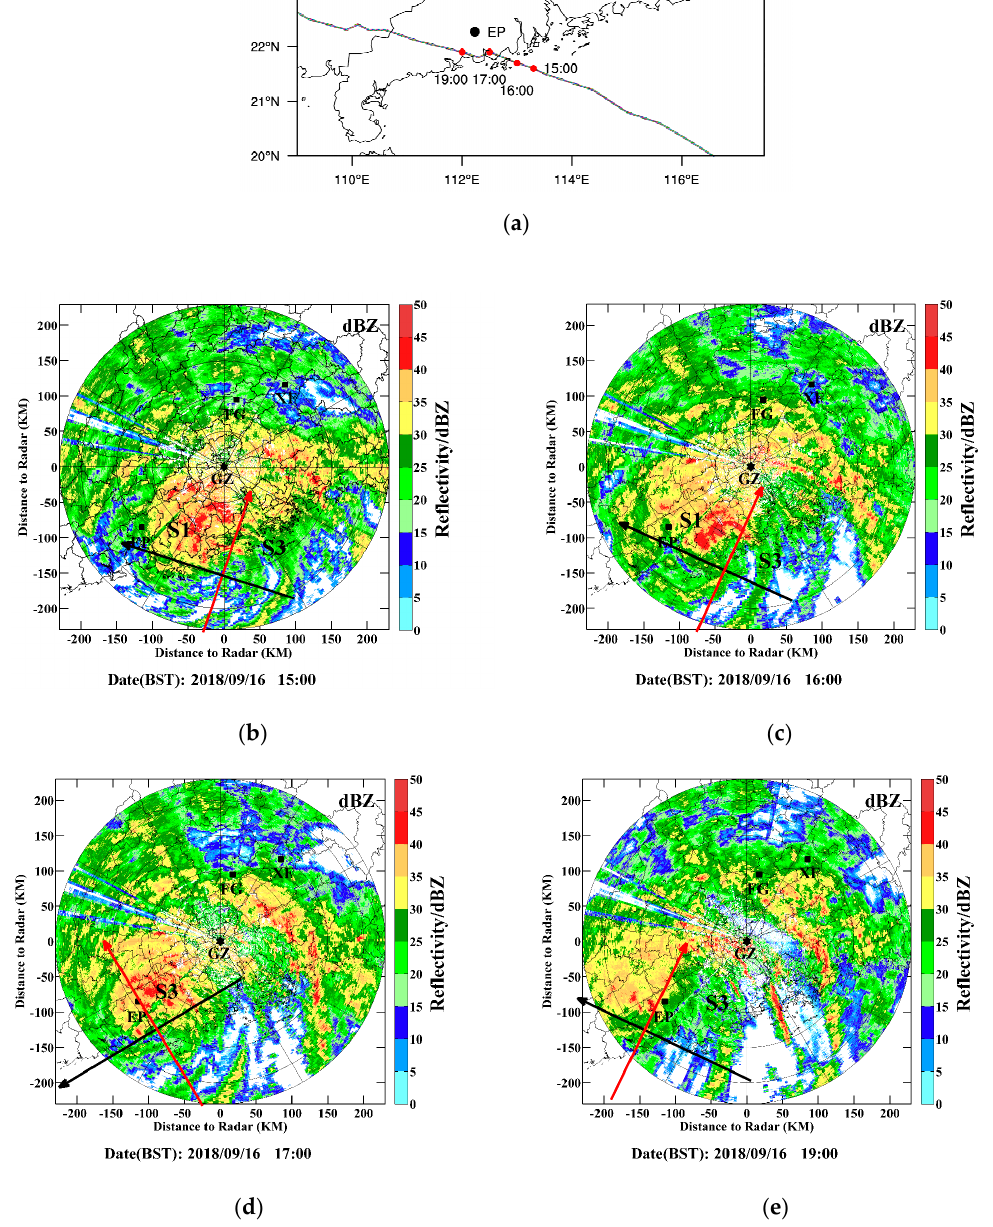
Figure 3. ( a ) Observed track of Typhoon Mangkhut, ( b – e ) radar reflectivity factor Z (dBZ) at 15:00 BST, 16:00 BST, 17:00 BST, and 19:00 BST, respectively. The solid black arrow is the movement direction of Typhoon Mangkhut. The solid red arrow is the direction perpendicular to the solid black arrow. The two lines intersect in the typhoon’s eye.